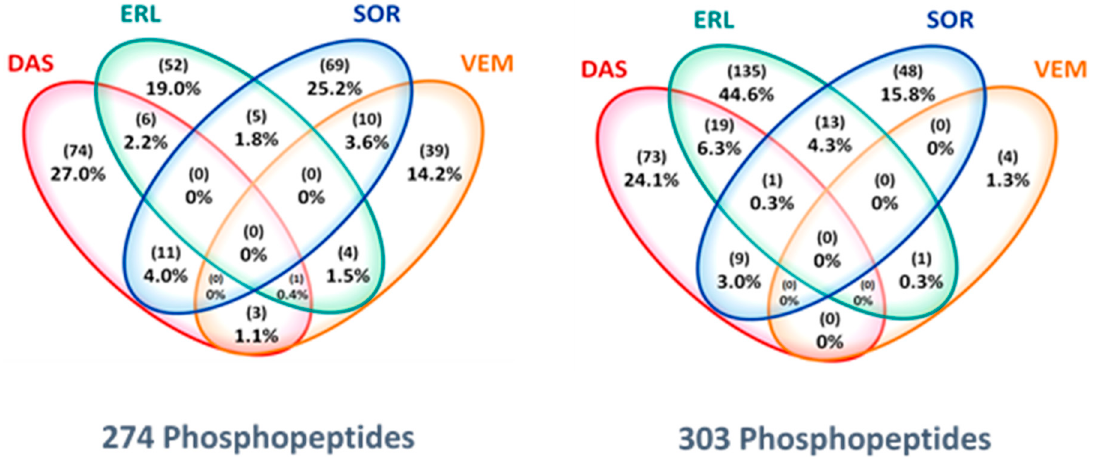
Figure 3. Drug-specificity of PKI-regulated phosphopeptides. Venn diagram depicts the overlap between observed upregulated (left) and downregulated (right) phosphopeptides per cohort, indicating these are PKI-specific. Analysis based on up- or downregulated phosphopeptides with a fold-change (On-tx / Pre-tx) of > 1.5 of observed phosphopeptide intensities, in at least 3 patients per drug cohort ( VEM , 4 patients, SOR / ERL / DAS , 5 patients; SUN not shown).